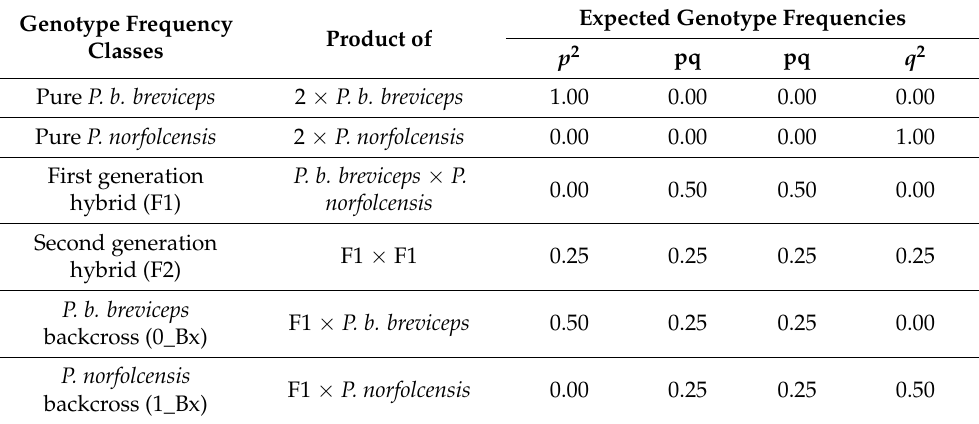
Table 1. NewHybrids genotype frequency classes tested with 200